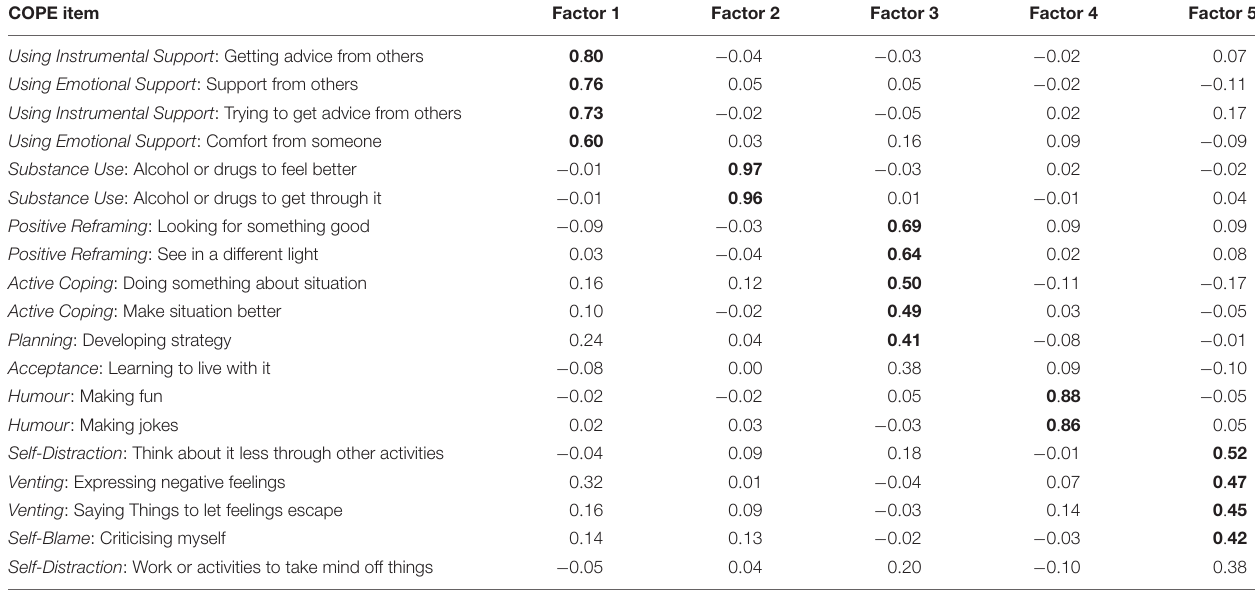
TABLE 4 | Exploratory factor analysis of COPE.